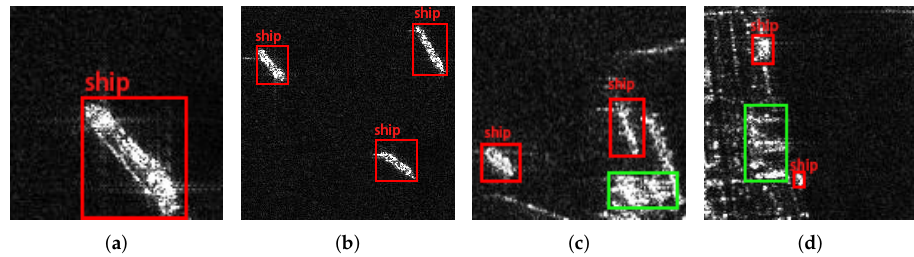
Figure 2. Ships with different background in SAR images. Ships are significantly brighter on SAR images than on the sea surface. The ship targets are marked in red boxes, and the strong scattering points on land are marked in green boxes. ( a ) Example 1 of ship’s brightness. ( b ) Example 2 of ships’ brightness. ( c ) Example 3 of the brightness difference between ships and land. ( d ) Example 4 of the brightness difference between ships and land.